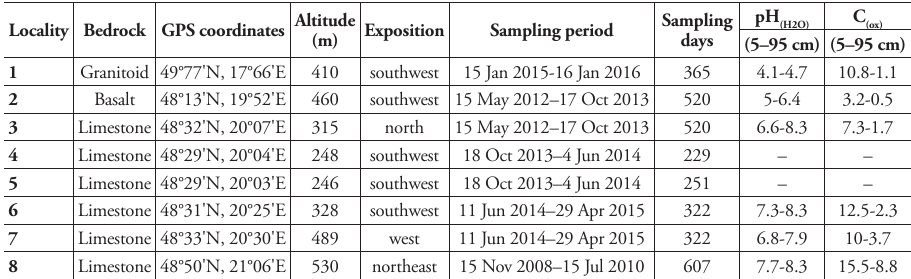
Table 1. Characteristics of scree slope sites studied. pH (2016b), were measured at four depths (5, 35, 55, and 95 cm). The numbers indicating particular studied scree slopes are stated in Figure